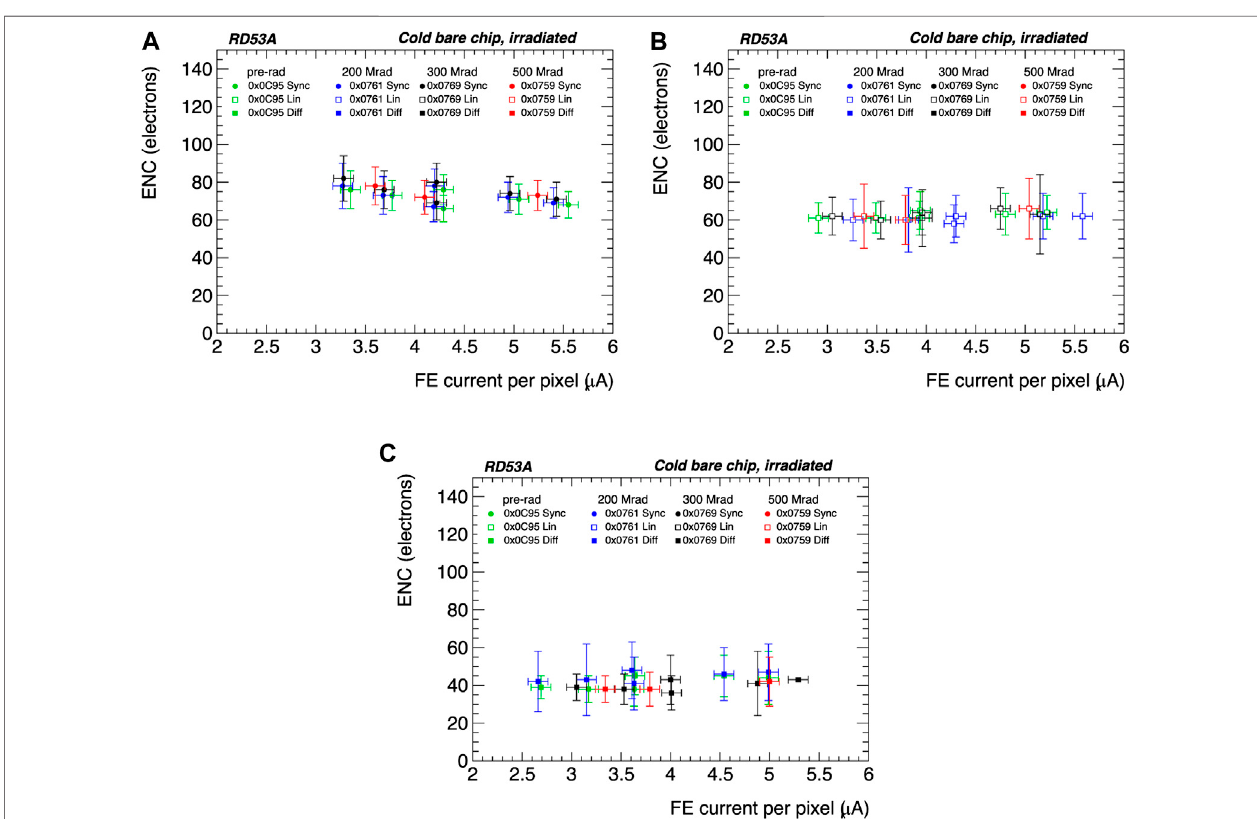
FIGURE 6 | ENC vs current consumption for three different RD53A analog front-ends (A,B,C) at different irradiation doses From [26].